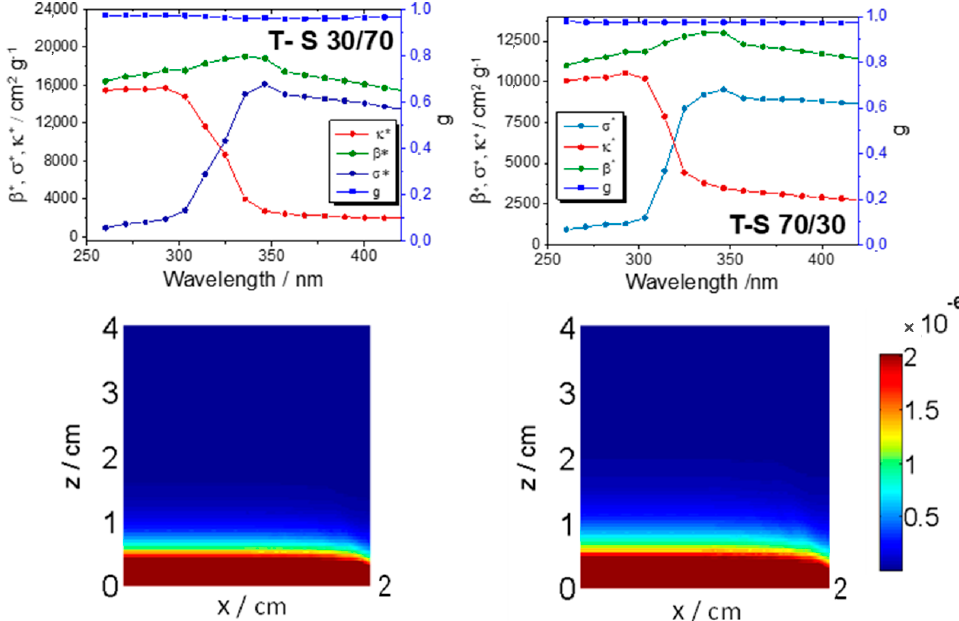
Figure 1. T sample optical properties and volumetric rate of photon absorption (Einstein cm − 3 s − 1 ) for lean and rich methanol mixtures.